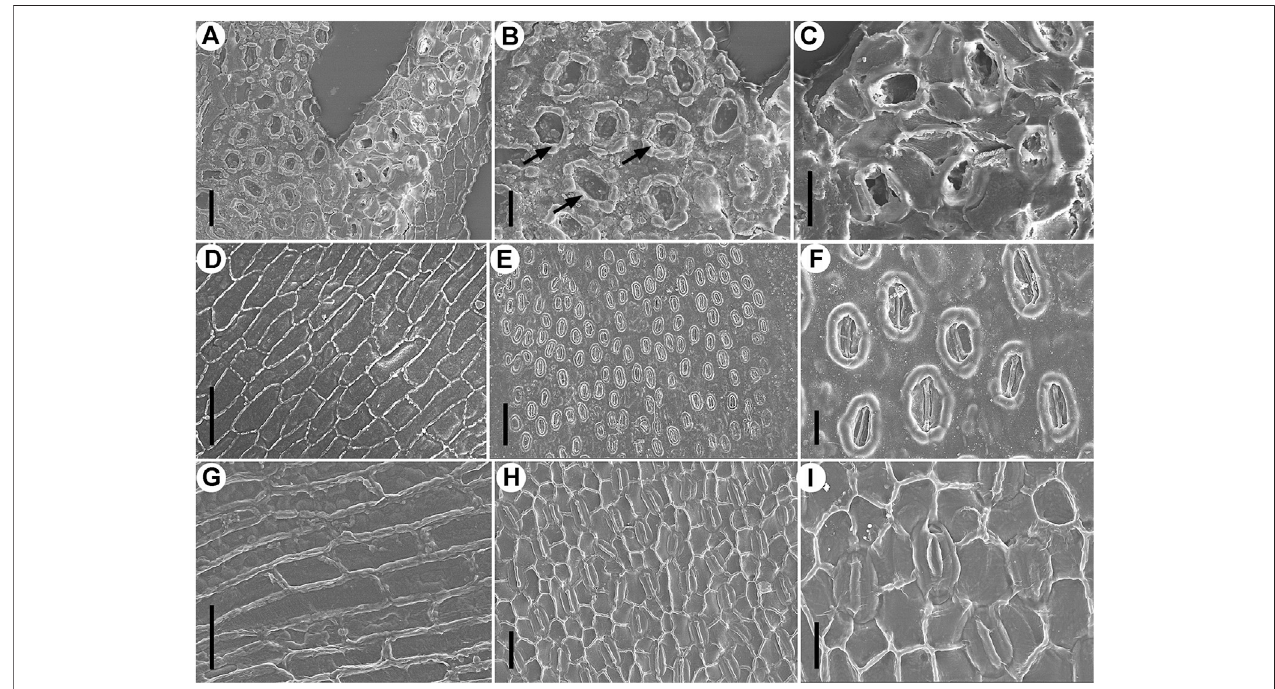
FIGURE5| Epidermalcharacters of Fokieniatianpingensis sp.nov. (A – D) and extant Fokieniahodginsii (Dunn)Henry&Thomas (E – I) ,SEM. (A) Abaxialcuticleofa lateral leaf on the underside of a branchlet showing a stomatal band, outer (left) and inner (right) view , TX-63 – 2. (B) Enlargement of the stomatal band (outer view) in (A) showing Florin rings (arrows) and papillae. (C) Enlargement of stomata (inner view) in (A) sharing subsidiary cells. (D) Abaxial cuticle of a lateral leaf on the underside of a branchlet showing the morphology and arrangementofordinary epidermalcells ofa non-stomatal zone, inner view, TX-63 – 2. (E) Abaxialsurface ofalateral leaf on theundersideofabranchlet,outerview. (F) Enlargementofstomatain (E) . (G) Abaxialcuticleofalateralleafontheundersideofabranchletshowingthemorphologyand arrangement of ordinary epidermal cells of a non-stomatal zone, inner view. (H) Abaxial cuticle of a lateral leaf on the underside of a branchlet showing a stomatal band, inner view. (I) Enlargement of stomata in (H) sharing subsidiary cells. Scale bars for (A, D, G, H) (cid:1) 40 μ m, (B, C, F, I) (cid:1) 20 μ